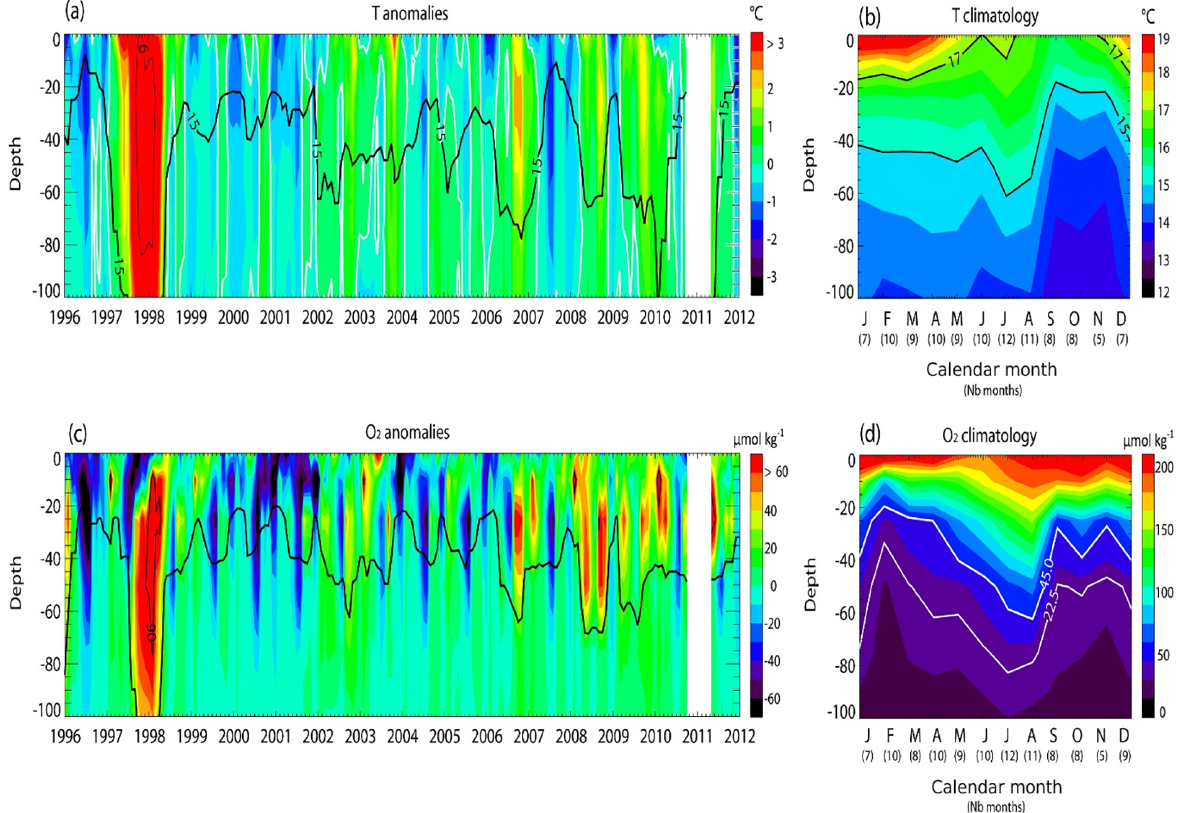
Figure 3. Temperature (top) and oxygen (bottom) anomalies relative to the mean climatology (a, c) and the respective climatologies (b, d) . The 15 ◦ C isotherm is indicated as a thick black line in panel (a) . The 45µmolkg − 1 iso-contour for total oxygen concentration (oxycline) is overplotted in panel (c) as a thick black line, while the 90µmolkg − 1 iso-contour for anomalies is drawn as a thin black line in order to visualize the amplitude of the anomalies during the 1997–1998 El Niño event. The number of years to derive the climatology is indicated in panels (b) and (d) below the calendar months.